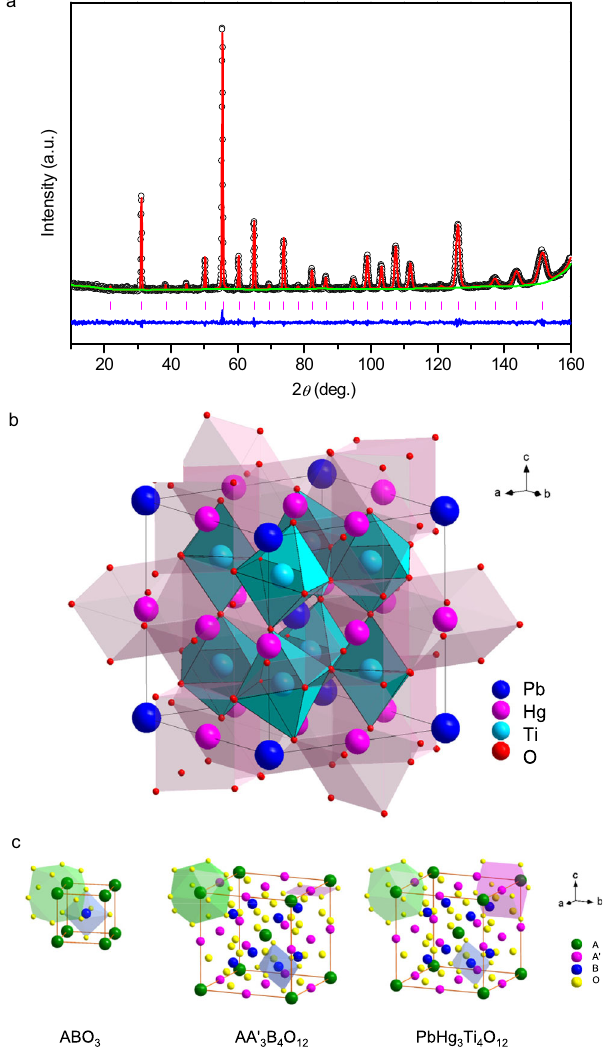
Fig. 1 Neutron diffraction and crystal structure of PHTO. a Rietveld re fi nements based on NPD data at 295 K. Observed (crosses), calculated (red), difference (blue) are shown in the fi gure, respectively. The ticks indicate the allowed Bragg re fl ections with space group Im -3. b Crystal structure of PHTO. c , Schematic coordination of A, A ′ and B-site for ABO 3 , AA ′ 3 B 4 O 12 and PbHg 3 Ti 4 O 12